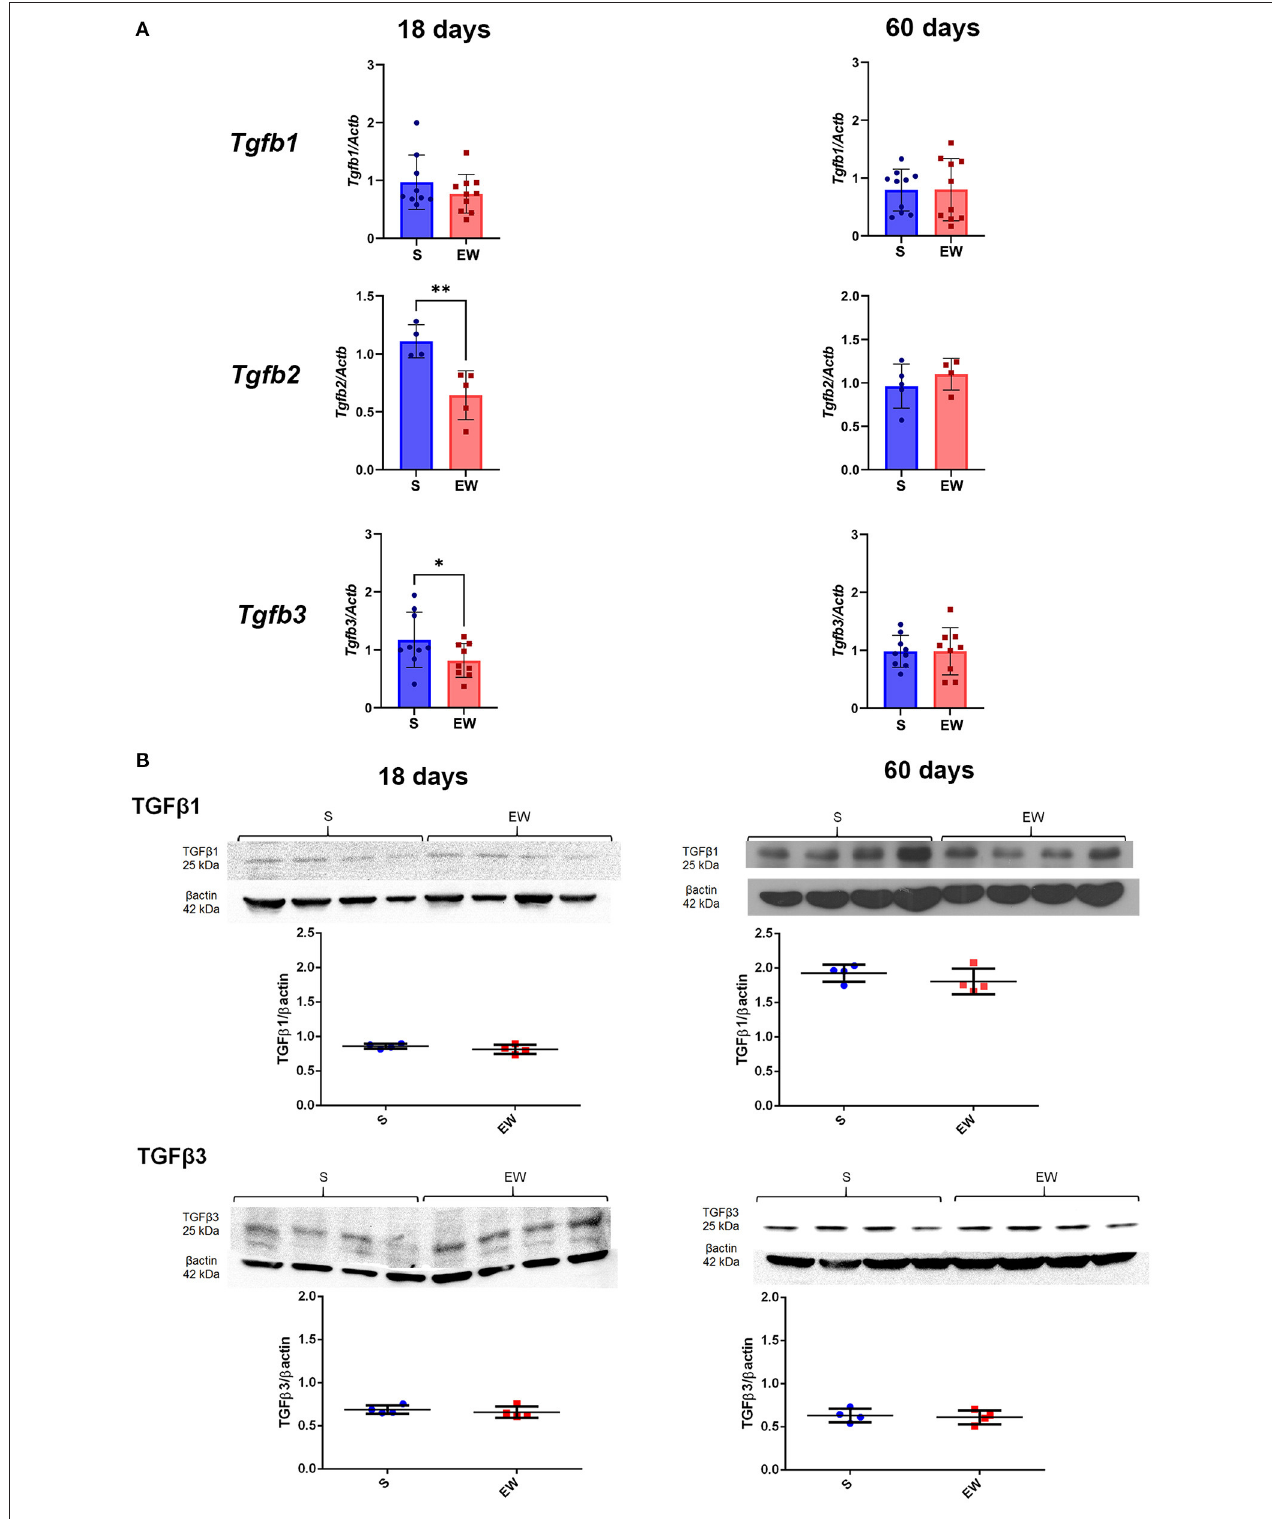
FIGURE 4 | Differential effects of early weaning on gene expression and protein levels of the TGF beta isoforms. (A) Tgfb1 , Tgfb2 , and Tgfb3 expressions in S (blue) and EW (red) groups at 18 and 60 days after RT-qPCR. (B) Representative immunoblots for TGF β 1 and TGF β 3 and respective β -actin loads (four samples/group). Densitometry was used to compare the integrated optical density (IOD) of each isoform in each sample to β -actin control. Results are represented individually for S (blue) and EW (red) and by means ± SD * p < 0.05 and ** p < 0.01 after Student’s t -test.